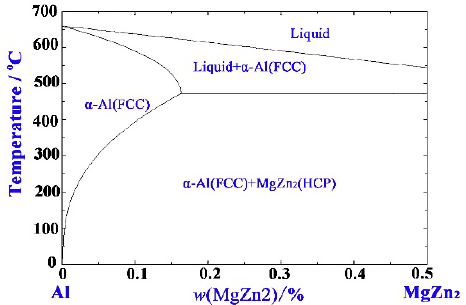
Figure 1. The equilibrium phase diagram of Al-MgZn 2 pseudo-binary system.